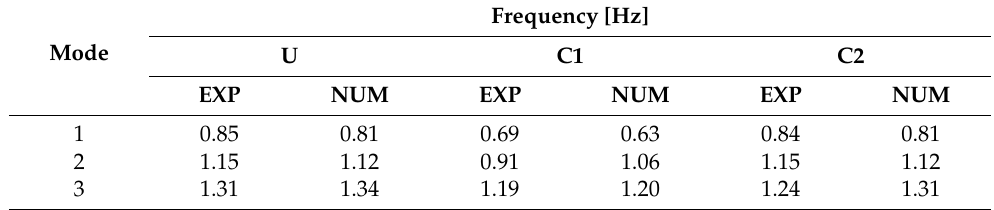
Table 6. Comparison between experimental and numerical frequencies during loading